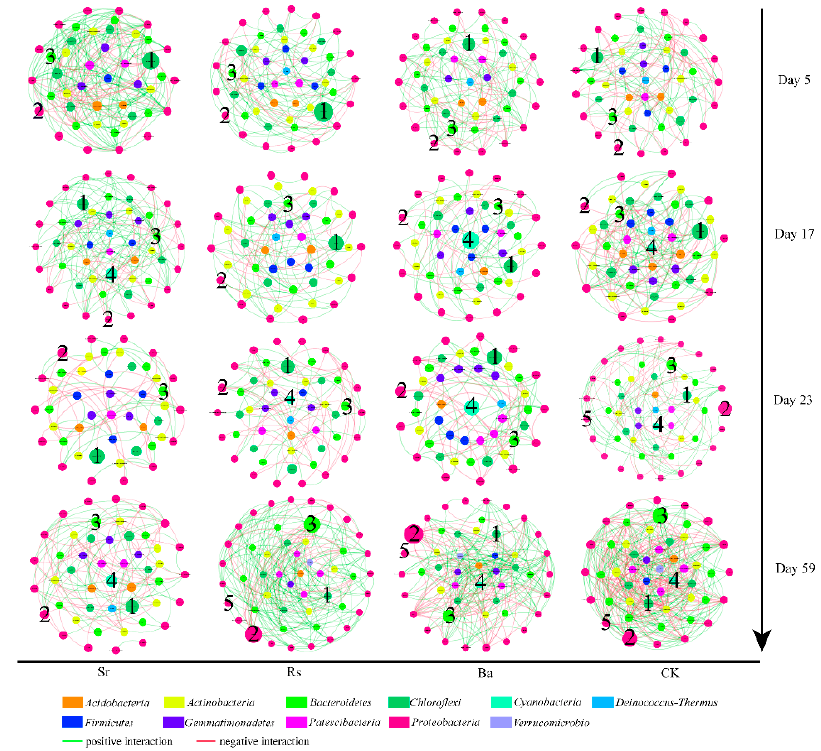
Figure 5. Networks at the genus level. The size of each node is proportional to the abundance of the genus it represents. Node color corresponds to phylum-level taxonomic classification. Edge color represents positive (green) and negative (red) interactions. Genera classified as (1) Chloroflexi ; (2) Pseudomonas ; (3) Flavobacterium ; (4) Cyanobacteria ; and (5) Rhizobium .